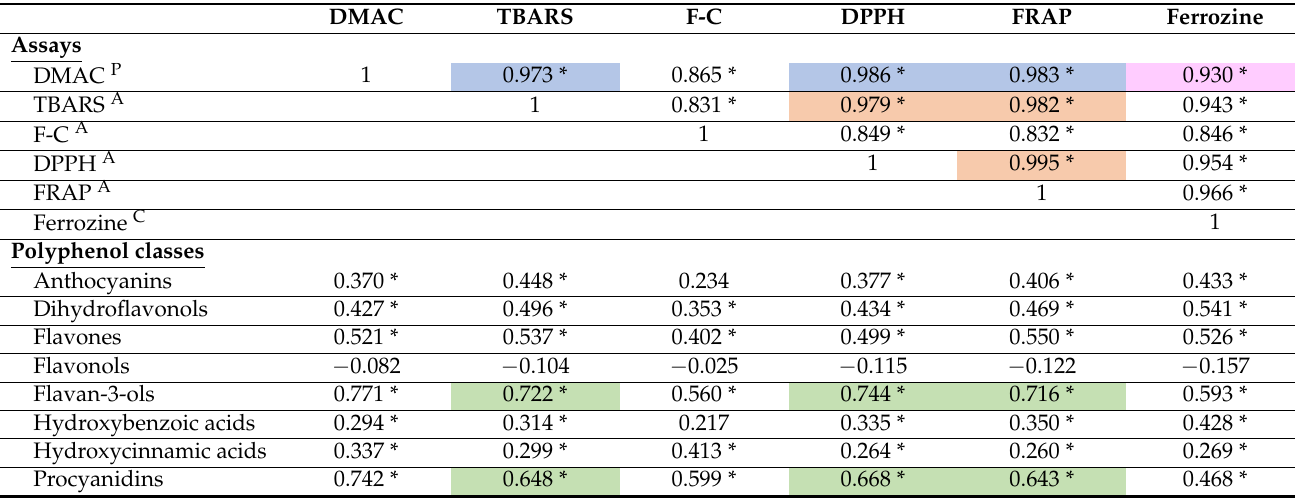
Table 1. Pearson correlations among the measured assays and polyphenol subclasses previously measured in pulse seed coat extracts. Excluding the antioxidant capacity measured by the F-C assay, green-highlighted cells refer to the highest correlations between polyphenol classes and antioxidant capacity, orange-highlighted cells refer to the correlations of antioxidant capacity measured by different assays, blue-highlighted cells refer to the correlations between proanthocyanidin content and antioxidant capacity, and pink-highlighted cells refer to the correlation between proanthocyanidin content and iron chelation ability.